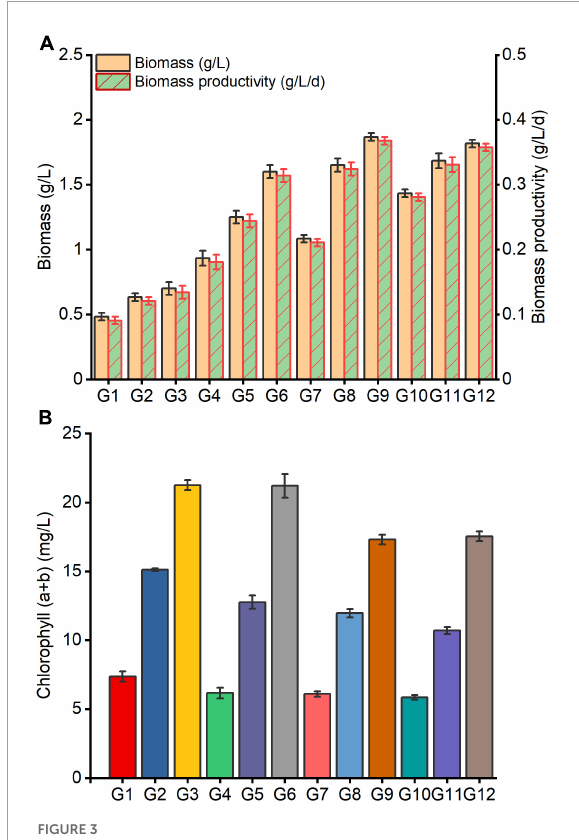
FIGURE3 Growth of C. reinhardtii under different carbon and nitrogen levels. (A) Shows the changes of biomass and biomass productivity; (B) indicates the changes of chlorophyll ( a + b ). G1-G12 represent the combinations of different NaAc (0, 2, 4, and 6 g/L) and various NH 4 Cl (0.09, 0.19, and 0.28 g/L) in turn as shown in Table 1 , and the following figures are the